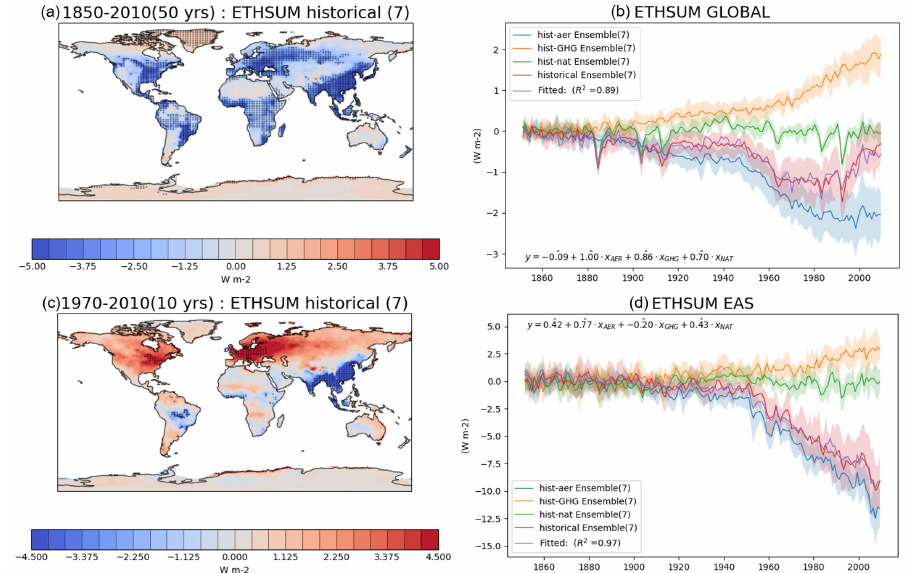
Figure 4. Result of the Net Radiation (ETHSUM) analysis: ( a ) 50-year mean start-to-end differences in net radiation (1850–2010); ( b ) time series plot of global net radiation; ( c ) 10-year mean start-to- end differences in net radiation (1970–2010); ( d ) time series plot of global net radiation. The titles above the plots and the legends within the plots are followed by the number of ensemble models in parentheses, and the estimated parameters with hats indicate statistical significance. On the maps, dots indicate where the differences are significant ( p -value ≤